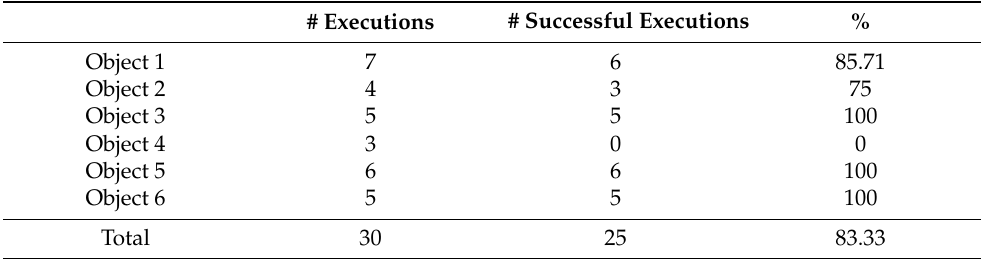
Table 2. Overall operation